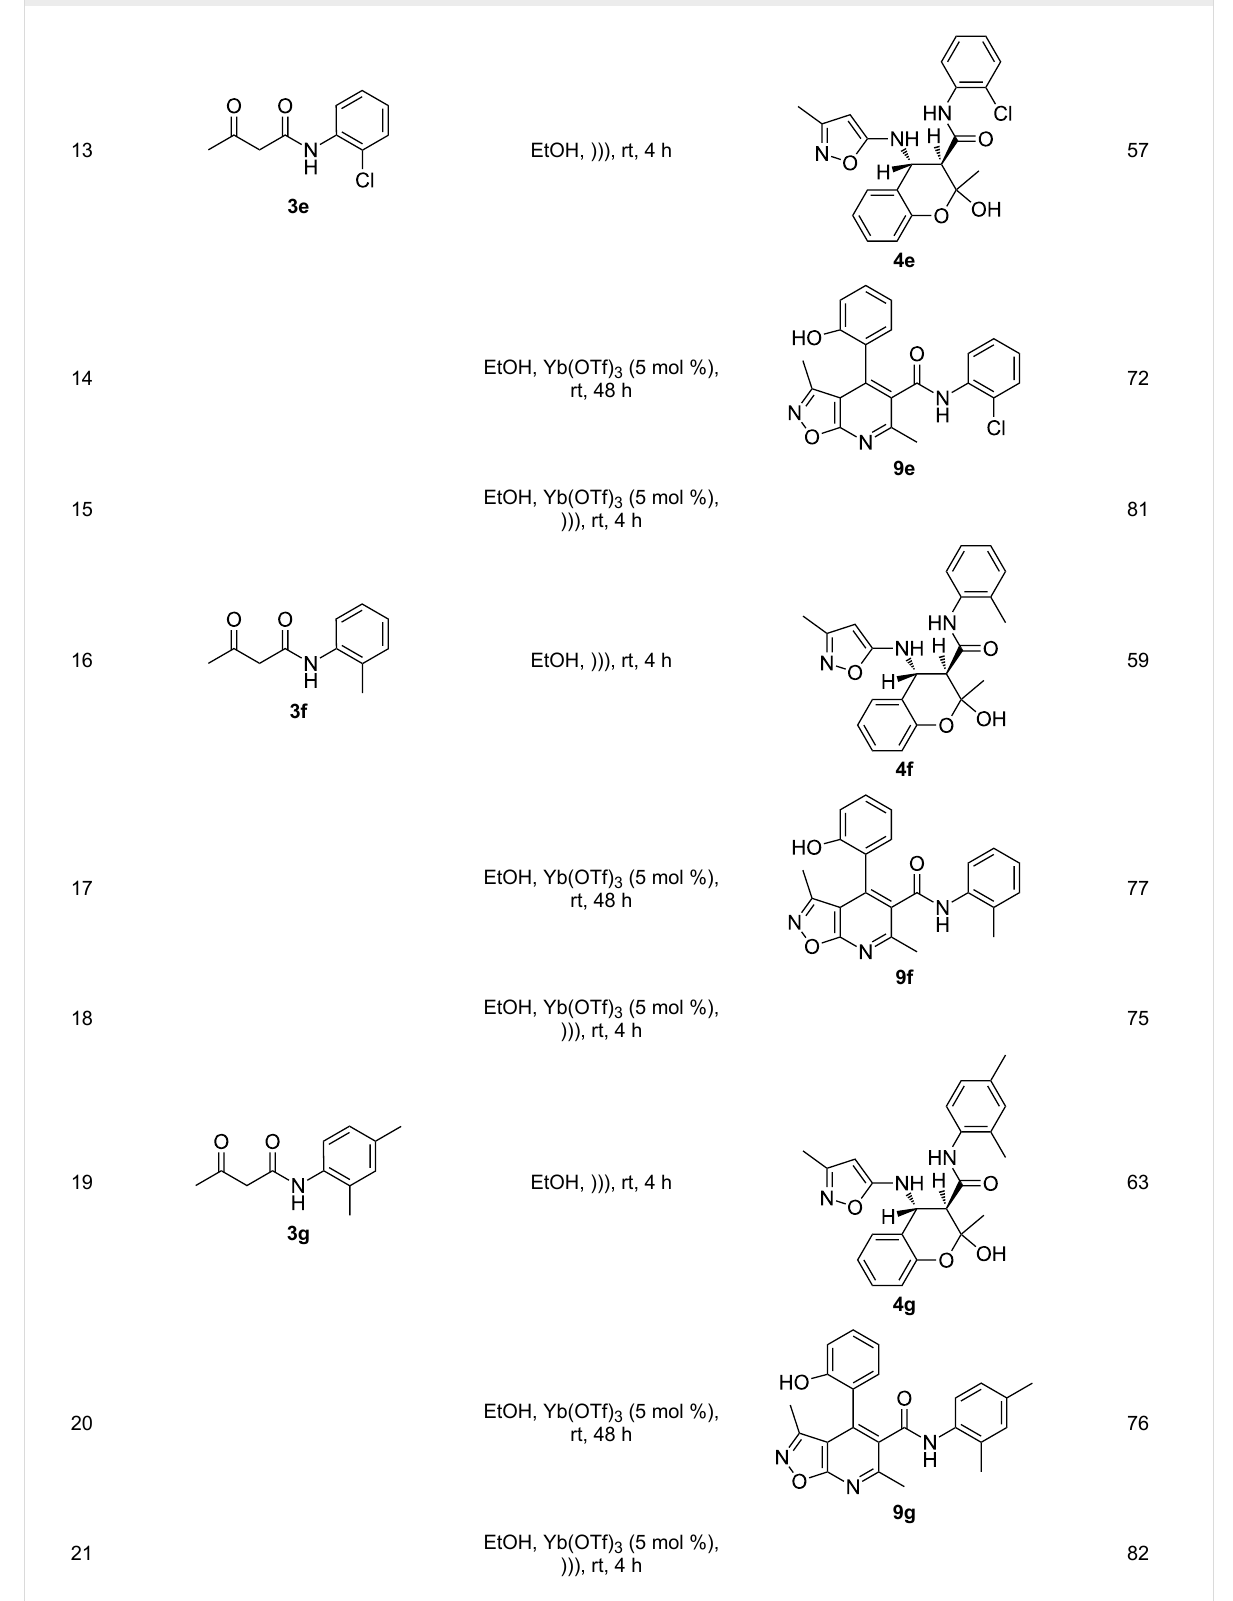
Table 3: Three-component heterocyclization of 5-amino-3-methylisoxazole ( 1 ), salicylaldehyde ( 2 ) and N -aryl-3-oxobutanamides ( 3a – h ).